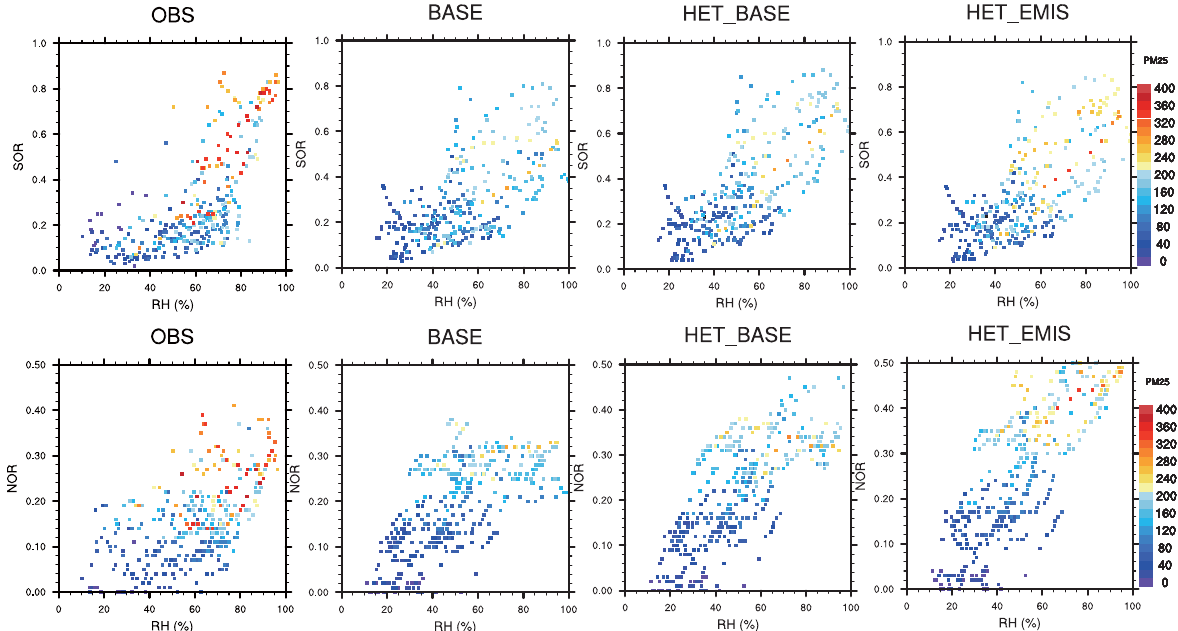
Figure 8. Observed (OBS) and simulated (BASE, HET_BASE, HET_EMIS) sulfur (SOR) and nitric (NOR) oxidation rates in PM 1 between 15 and 31 October. The x axis is the observed for left panels and simulated relative humidity for the other panels. Colors denote different PM 2 . 5 concentrations (µgm − 3